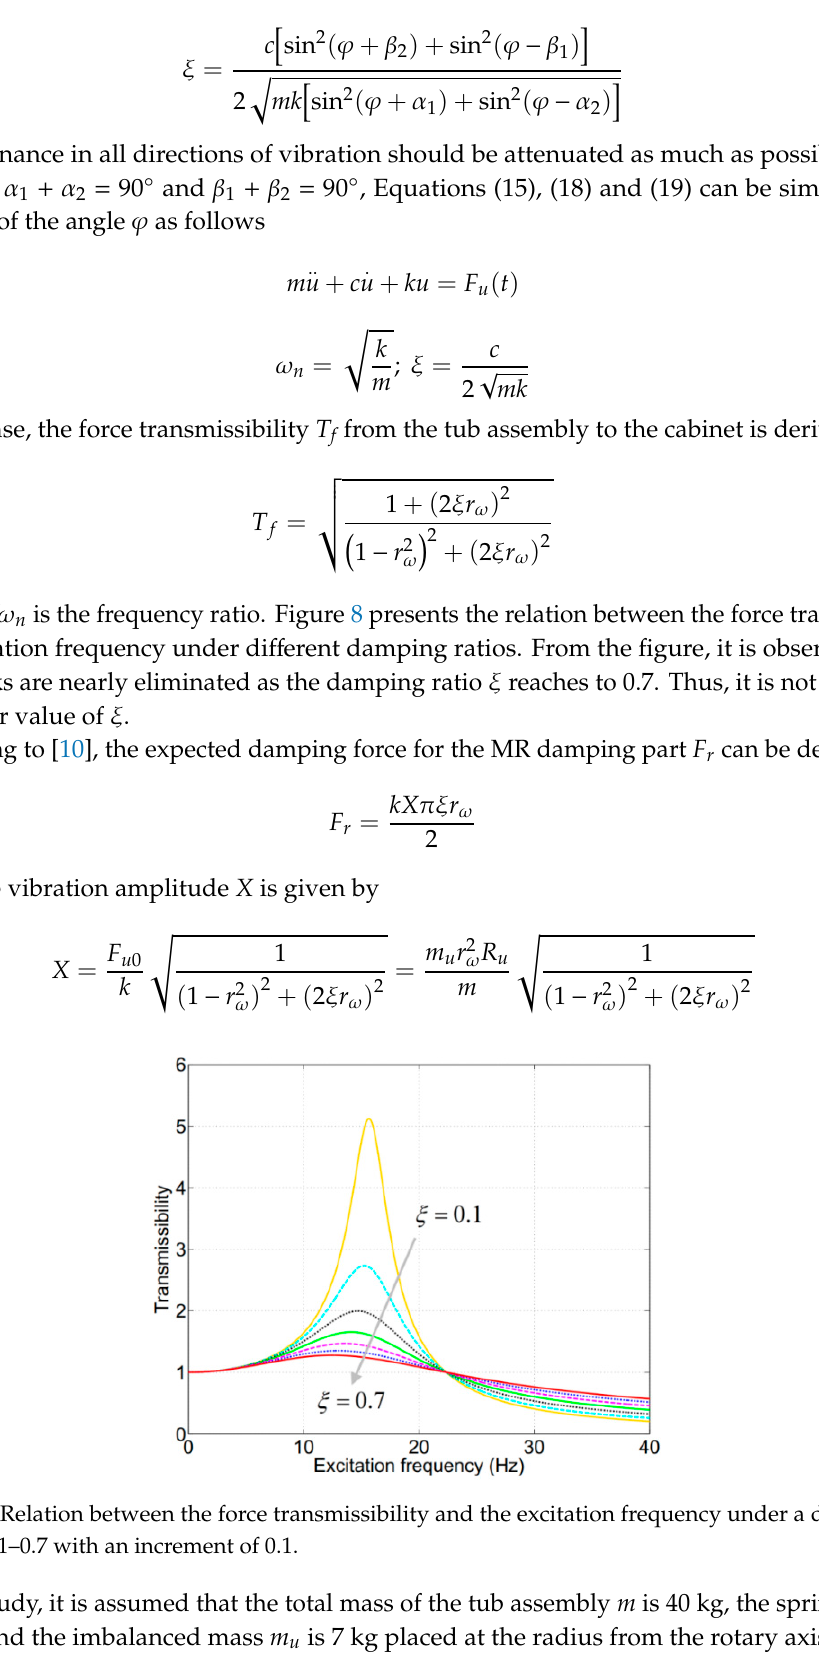
For the desired damping ratio ξ = 0.7 at the resonance frequency ratio r ω =